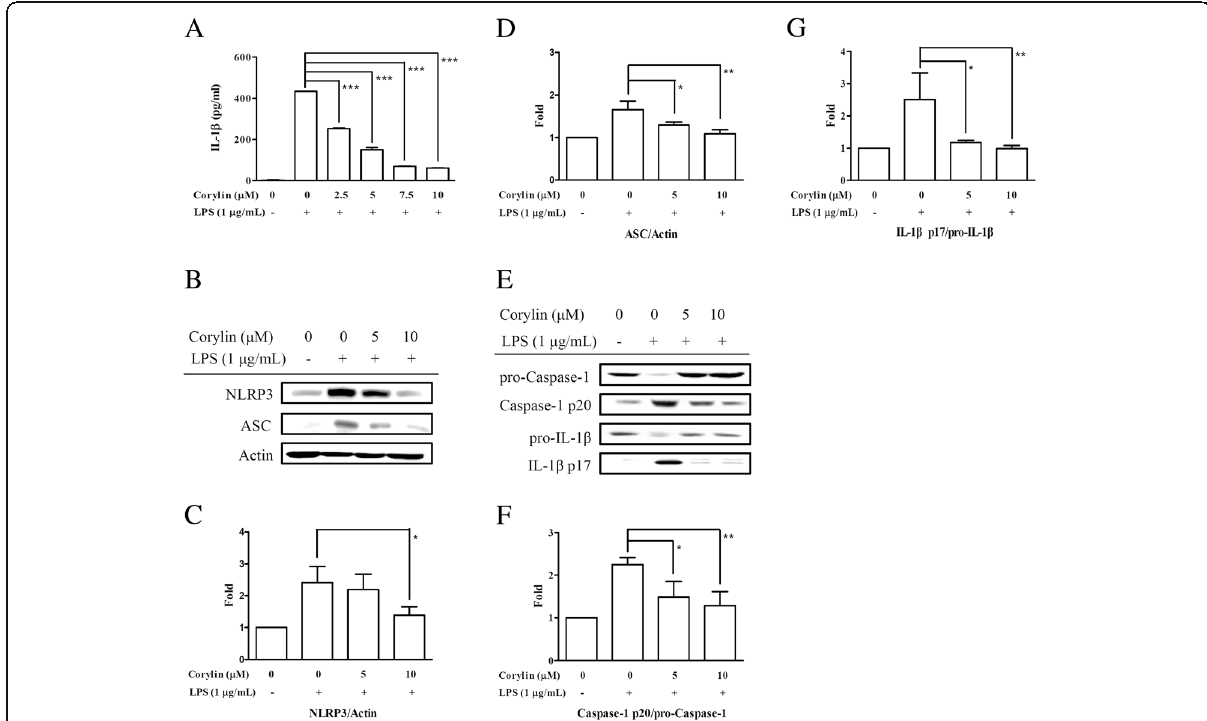
Fig. 4 Effects of corylin on the activation of NLRP3 inflammasome by LPS-activated BV2 cells. BV2 cells were incubated with various doses of corylin for 1 h, and then treated with LPS (1 μ g/mL) for 24 h or 48 h. a The level of IL-1 β in the cell culture supernatant was examined by ELISA (***: p < 0.001 vs. LPS alone). b The expression levels of NLRP3 and ASC were examined by Western blot. Blots are representative blots. c , d Quantitation was performed on three independent experiments and presented as the means ± SD. The expression of β -actin was used as an internal control. The relative ratios of NLRP3/ β -actin and ASC/ β -actin are shown (*: p < 0.05; **: p < 0.01 vs. LPS alone). e The expression levels of pro-caspase-1, mature caspase-1 (p20), pro-IL-1 β , and mature IL-1 β (p17) were examined by Western blot. Blots are representative blots. Quantitation was performed on three independent experiments and presented as the means ± SD. The relative ratio of f mature caspase-1 (p20)/immature caspase-1 and g mature IL-1 β (p17)/immature IL-1 β are shown (*: p < 0.05; **: p < 0.01 vs. LPS